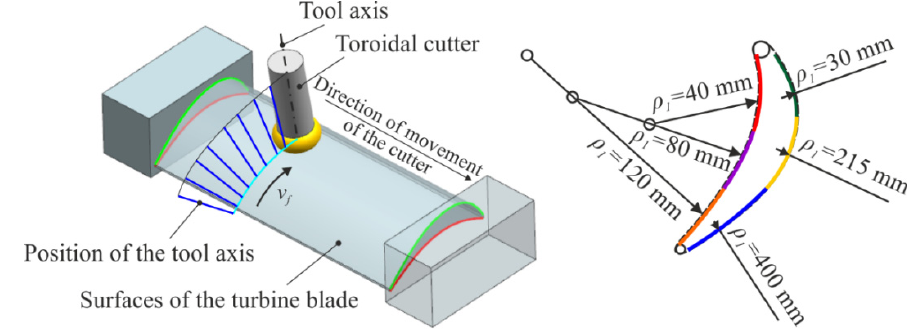
Figure 4. Research 3D-CAD model of the turbine blade.